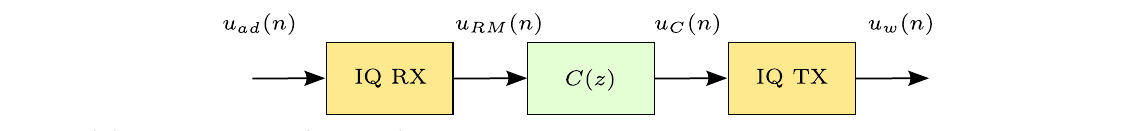
Fig. 7 I/Q imbalance compensation and SR-SI